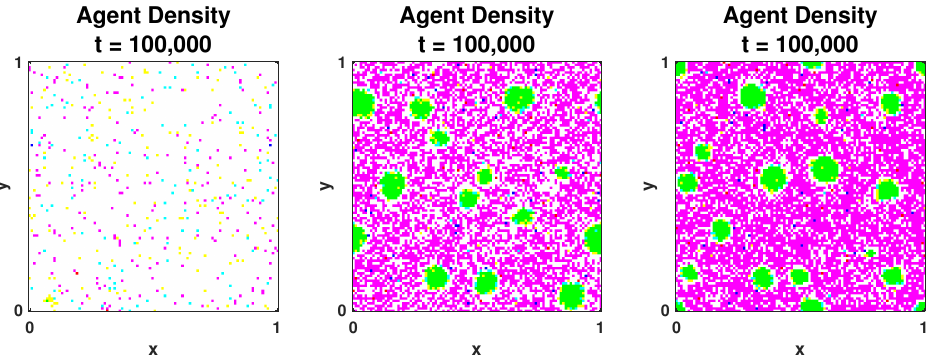
Figure 18. Agent density lattices for the first variation (Timidity Model) taken after 100,000 time steps = 1, and N = N = N = 50,000 agents. On all lattices, the first and second β for δ t = 1, L = 100, γ 2 3 1 λ values were fixed to β 1 = 6 × 10 − 6 , β 2 = 8 × 10 − 6 . Starting from the top left, the third β value used was 1 × 10 − 5 ,2.2 × 10 − 5 and β 3 = 3 × 10 − 5 , respectively. The color of gang 1 is red, while gang 2 and 3’s colors are blue and green, respectively. In the first lattice, β 1 β 2 β 3 < β ∗ , and this resulted in the agents being well-mixed. In the second and third lattice, β 1 β 2 β 3 > β ∗ , and this resulted in the agents